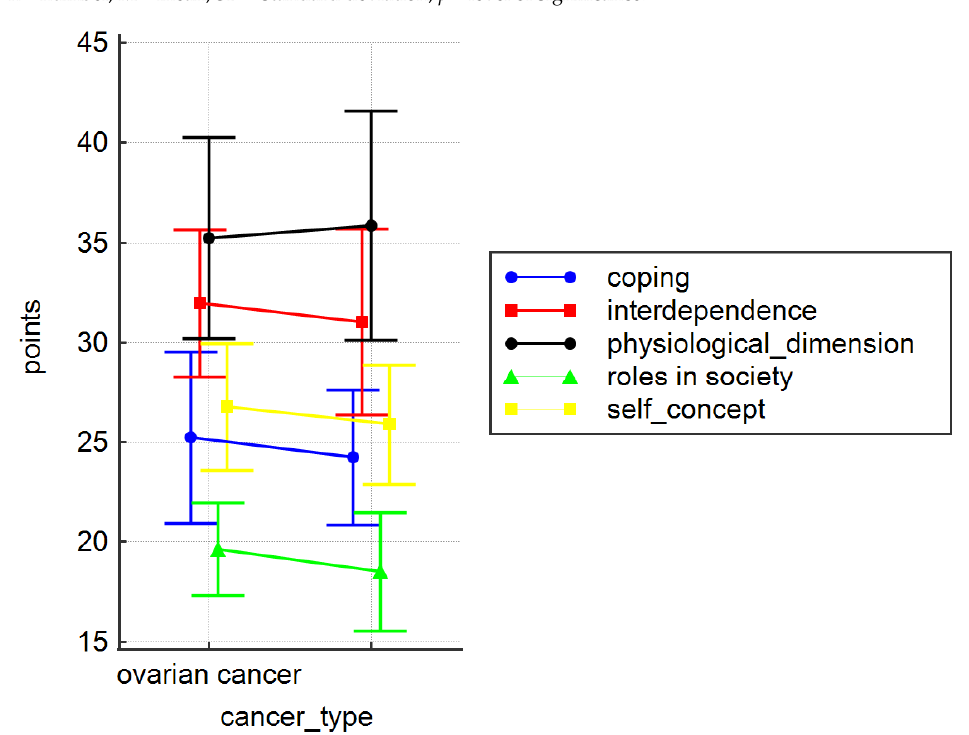
Figure 3. CAPS subscales by diagnosis. Means and standards deviations are given.